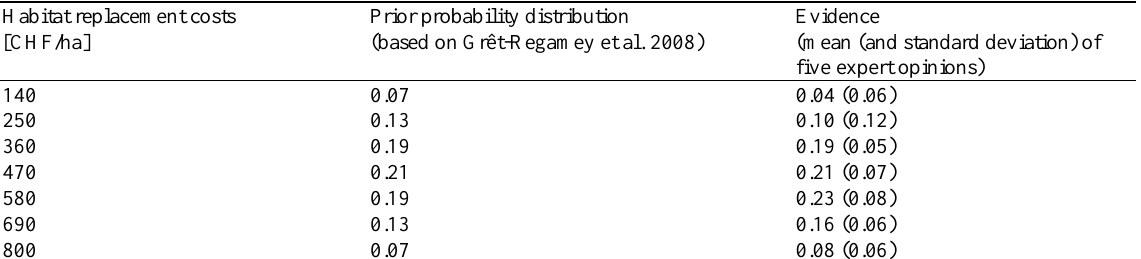
Table A3.3. Prior probability distribution of habitat replacement costs and evidence provided by experts. The evidence that was fed into the Bayesian Network was calculated as the mean value of the probability estimates for each state of the node provided by the single experts.